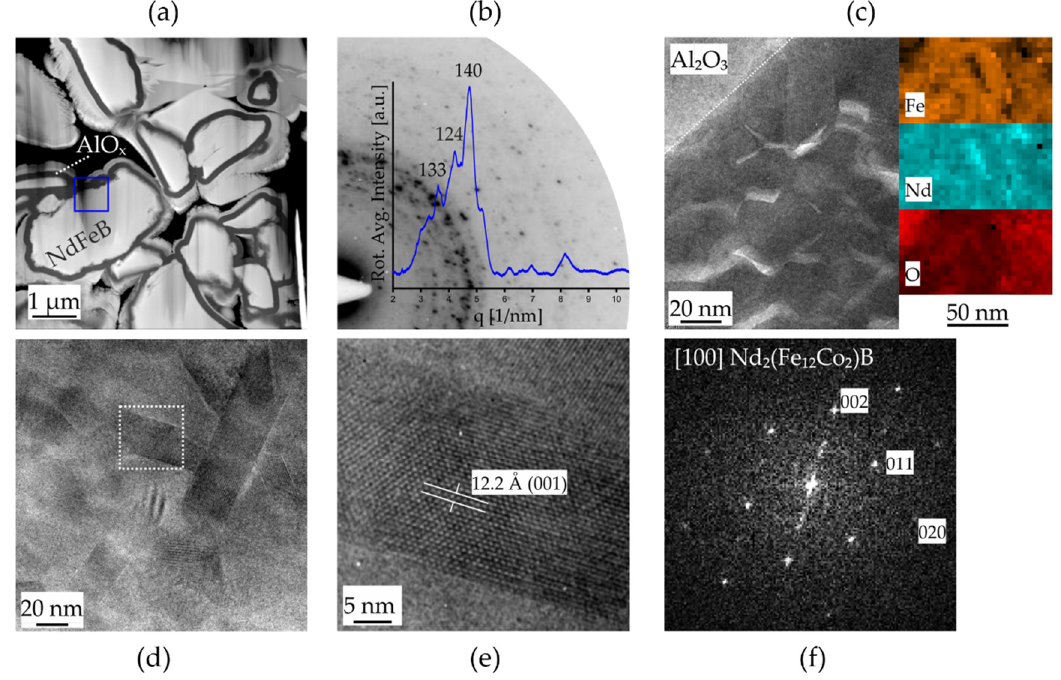
Figure 4. TEM investigation of NdFeB5 [Nd 2 (Fe 12 Co 2 )B] micropowder. ( a ) Scanning TEM image showing the microstructure morphology of NdFeB5 particles coated by a layer of amorphous Al 2 O 3 . ( b ) SAED pattern (inverted contrast) and its rotational intensity distribution of the area marked by the blue frame in ( a ). ( c ) HRTEM micrograph of the Al 2 O 3 /NdFeB interface region and STEM EDS mappings. ( d ) HRTEM micrograph of the nanocrystalline grain structure and ( e ) magnified view of one nanograin and ( f ) FFT image in [100] orientation confirming the tetragonal phase of Nd 2 (Fe 12 Co 2